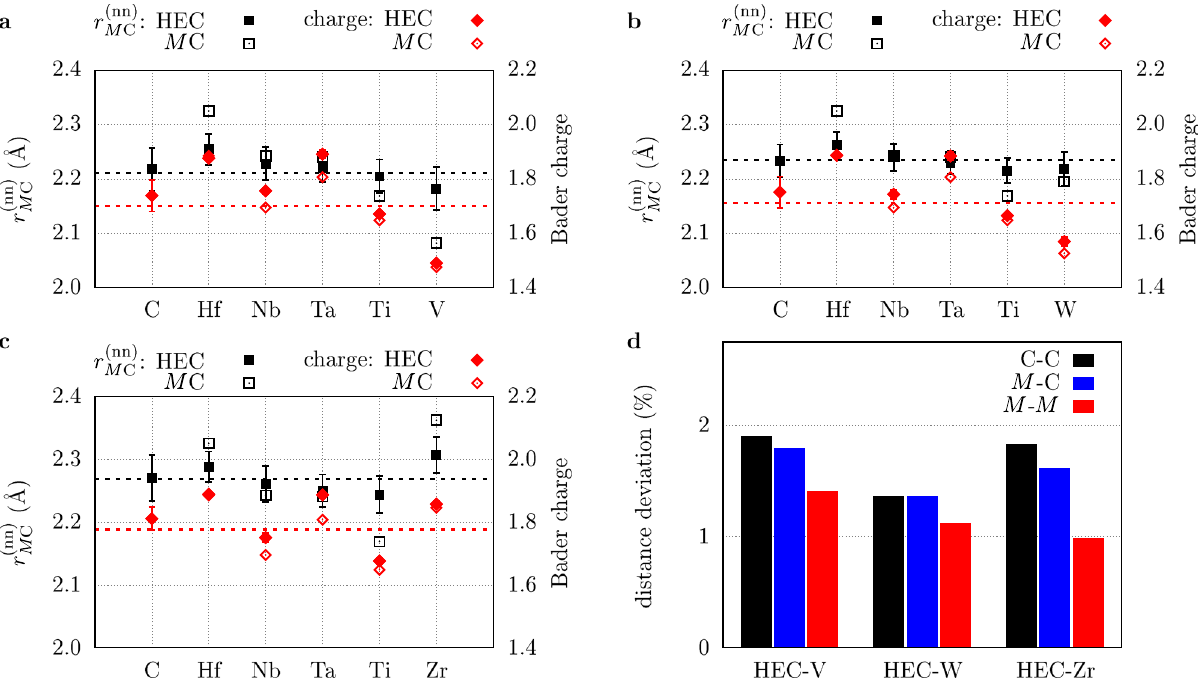
(black) and magnitude of the Bader charges (red) in C